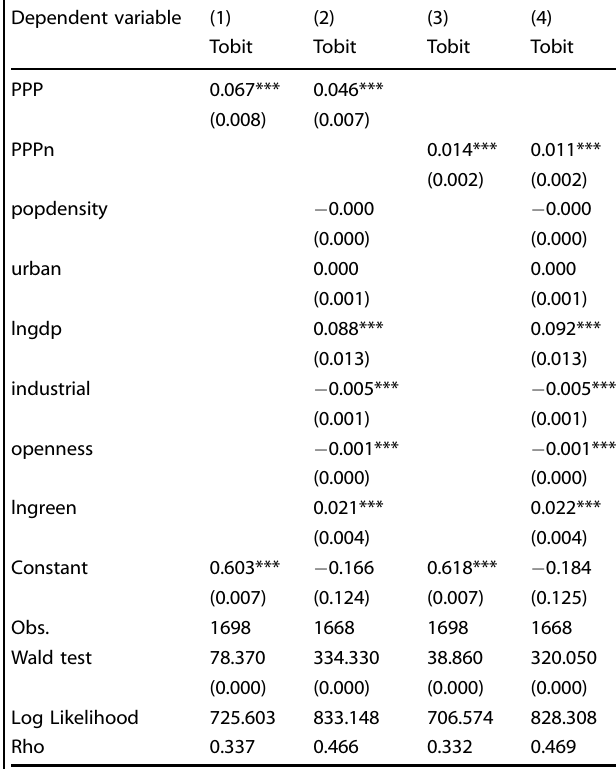
Table 1. Estimation results of the benchmark regression